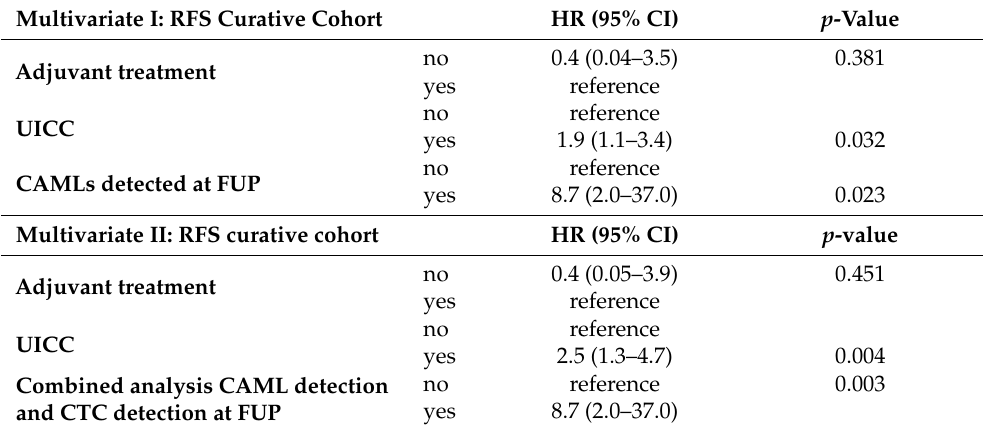
no 0.4 (0.04–3.5) 0.381 yes reference no reference yes 1.9 (1.1–3.4) 0.032 no reference yes 8.7 (2.0–37.0) 0.023 no 0.4 (0.05–3.9) yes